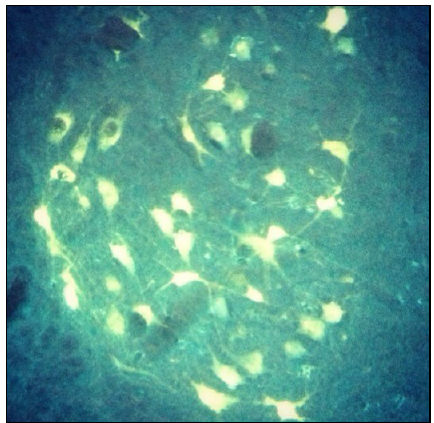
Figure 2 - Microscopy of the anterior